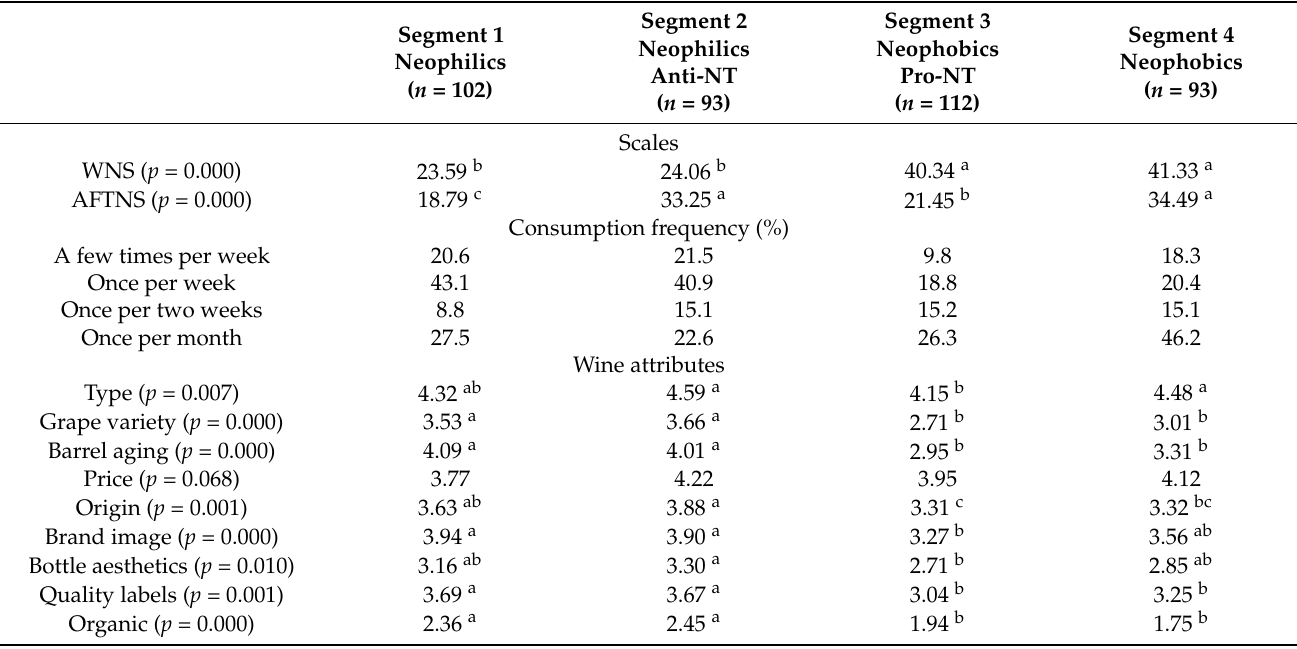
Table 3. Consumer segmentation according to Wine Neophobia Scale (WNS) and Abbreviated Food Technology Scale